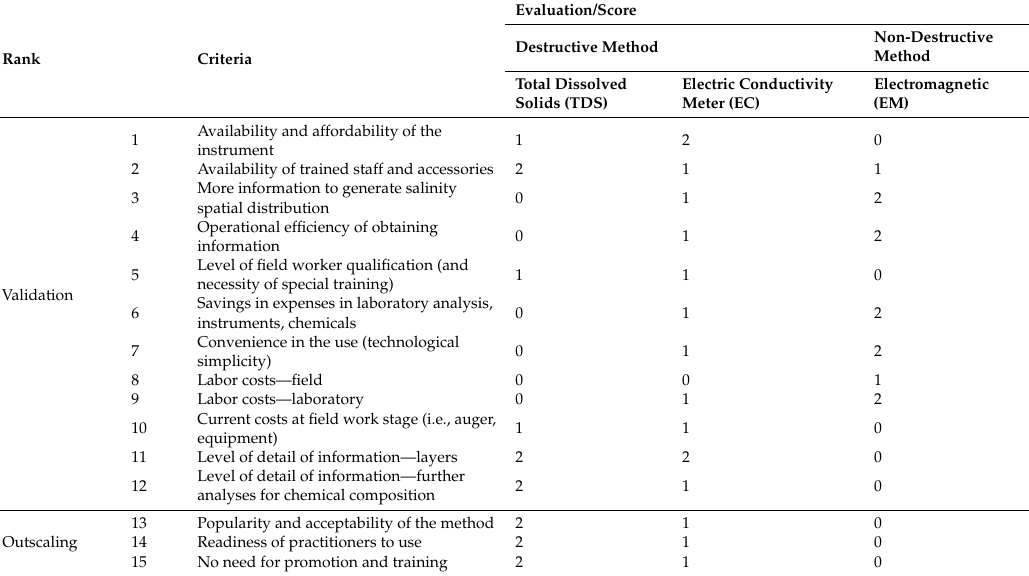
Table 3. Participatory evaluation of alternative salinity assessment